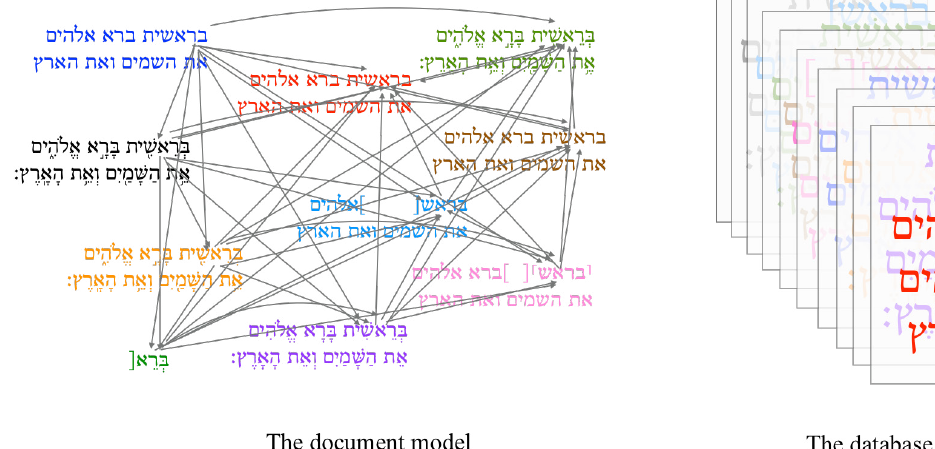
Figure 3: Comparing multiple texts in the document model and in the database model